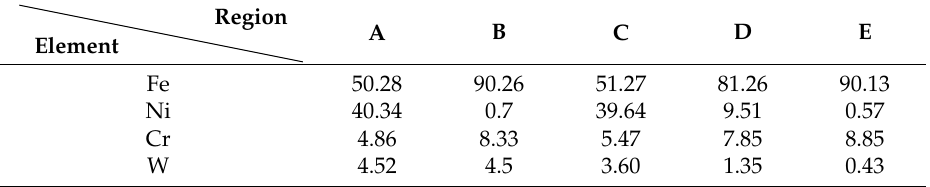
Table 3. EDS analysis results of the region marked with green rectangles in Figure 4b (wt.%). Region Element